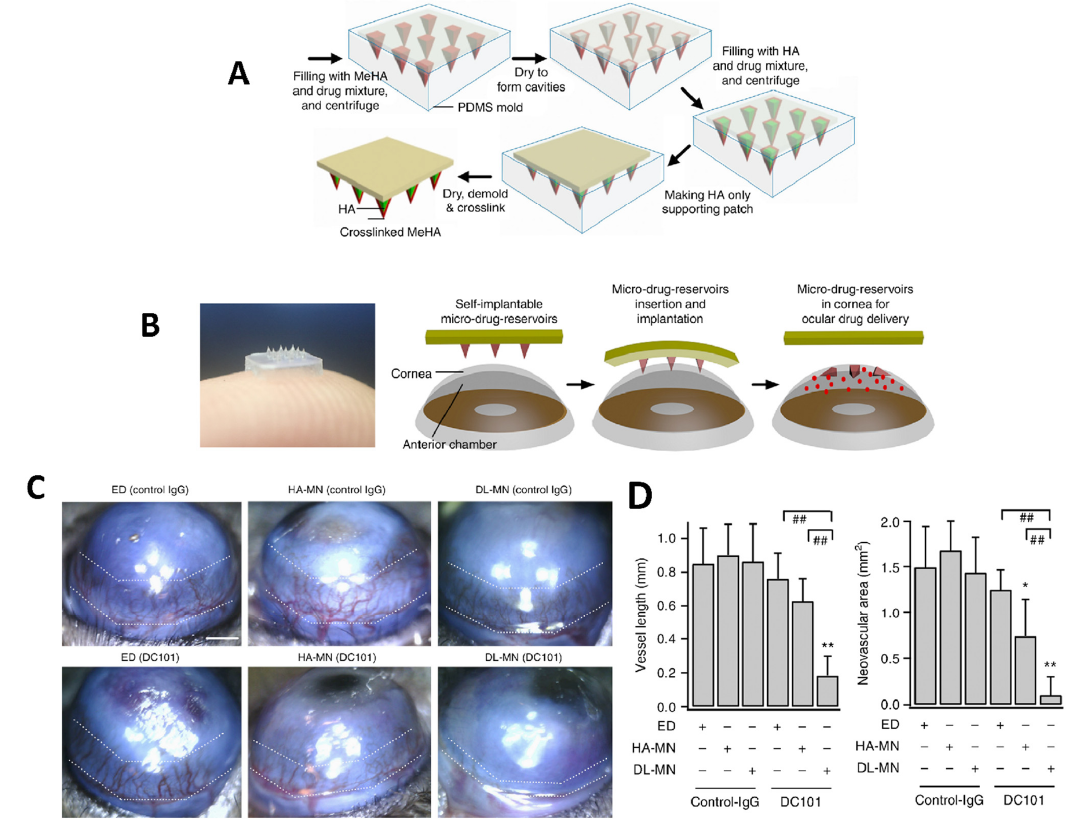
Figure 3. ( A ) Manufacturing process of the ocular polymeric patch equipped with MNs, ( B ) Sche- matic of MN-equipped eye-contact patch for ocular drug delivery, ( C ) Representative images of eyes treated with MNs. Scale bar = 500 μm, ( D ) Quantifications of corneal neovascularization (mean ± SEM; 6 samples for each group). The white dotted lines represent the extent of neovascular out- growth from the limbus (* p < 0.05, ** p < 0.01 vs. control, ## p < 0.01 between indicated pairs). Re- printed from [112] with permission from Springer Nature.